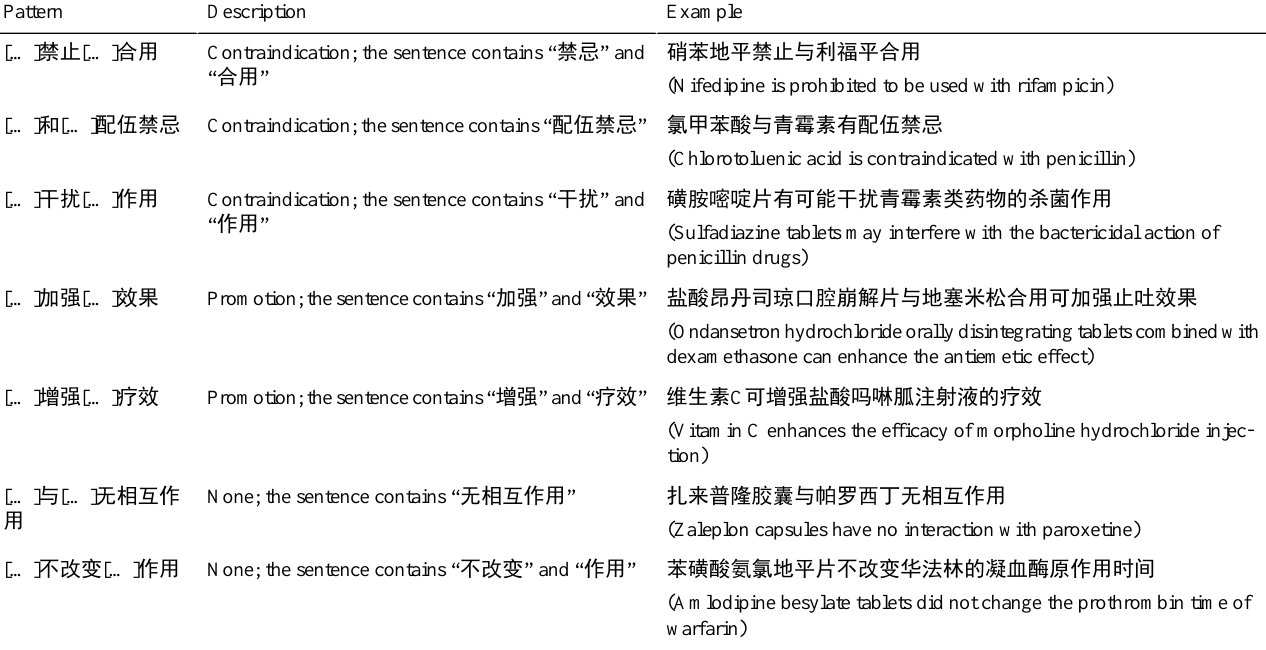
Table 5. Patterns for extracting drug-drug interaction relations. ExampleDescriptionPattern